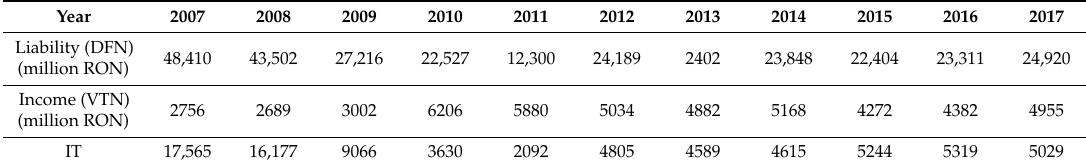
Table 7. NFI debt sustainability indicator (IT) values for the period 2007–2017.